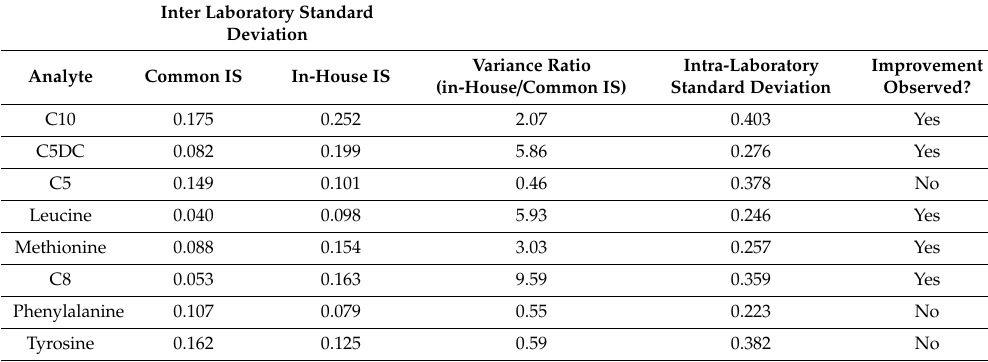
Table 2. Summary of fitted intra- and inter-laboratory standard deviations obtained from the mixed models described in the text. Variance ratios indicate the relative size of the between-laboratory variation for each analyte (values above 1 show an improvement observed when using the common IS). The last column indicates whether observed improvements were significant; this was based on whether separate random e ff ects were required for the two IS types. All standard deviations are shown in µ mol /